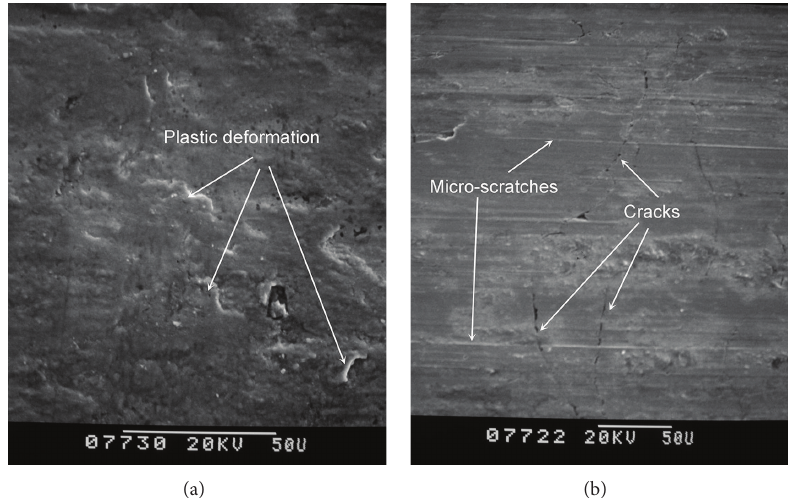
Figure 8: SEM micrographs of the worn surfaces of (a) quenched and tempered GCI; (b) boronized GCI at 1223K for 8h.